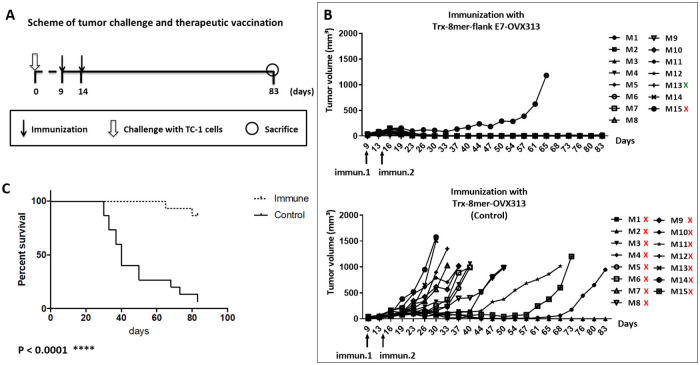
Vaccination with Trx-8mer-flank E7-OVX313 induces regression of advanced TC-1 tumors.(A) Experimental scheme of tumor challenge and therapeutic vaccination. Specifically, mice were inoculated with 0.3×106 TC-1 cells suspended in 100 μl of PBS on their right flank. When tumor size reached a diameter of 4-6mm, half of the tumor-bearing animals were immunized subcutaneously at the base of the tail with 20 μg of the Trx-8mer-flank E7-OVX313 antigen, whereas the remaining tumor-bearing mice received 20 μg of the control Trx-8mer-OVX313 antigen. Both antigens were adjuvanted with AddaVax, and two vaccine doses were administered 9 and 14 days after the challenge. Mice were excluded from the experiment when tumor diameter exceeded 1.5 cm. (B) Tumor growth curves of Trx-8mer-flank E7-OVX313 and Trx-8mer-OVX313 immunized mice (15 mice per group). (C) Animal survival rate displayed as Kaplan-Meier curves; the Log-rank test indicates a significant difference in survival (p<0.0001). Red crosses indicate mice that had to be sacrificed ahead of time due to an excessive tumor burden (tumor diameter over 1.5 cm). The mouse indicated by the green cross was sacrificed owing to skin lesions irrelevant to the tumor.